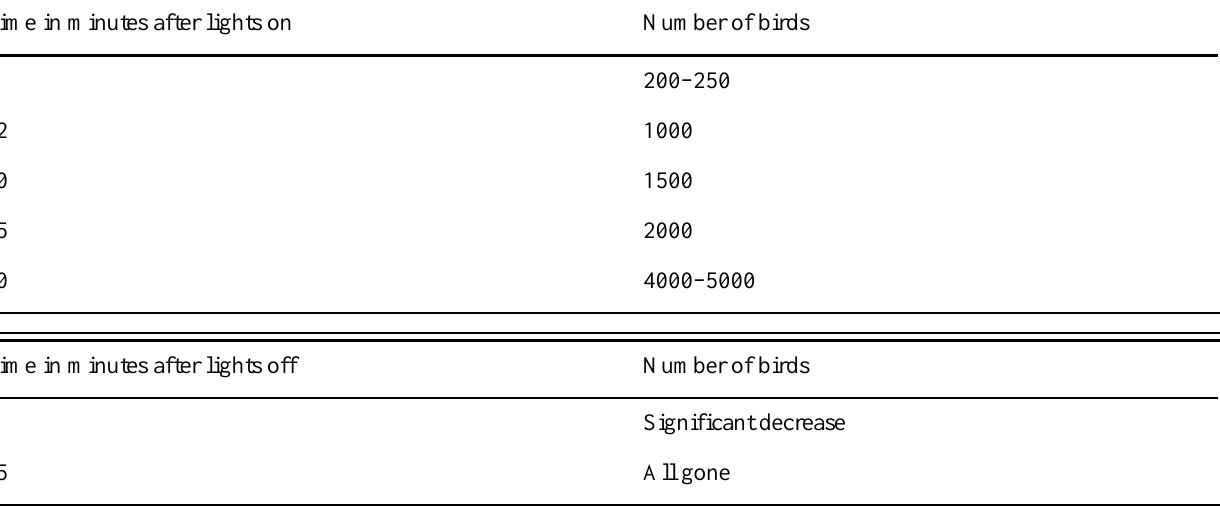
Table 1. Typical reaction rate of birds to light at sea during cloudy night migration as measured on the gas- production platform L5 (Marquenie and van de Laar 2004). The intensity of the lights when all lights were on, including main deck lights, was 30